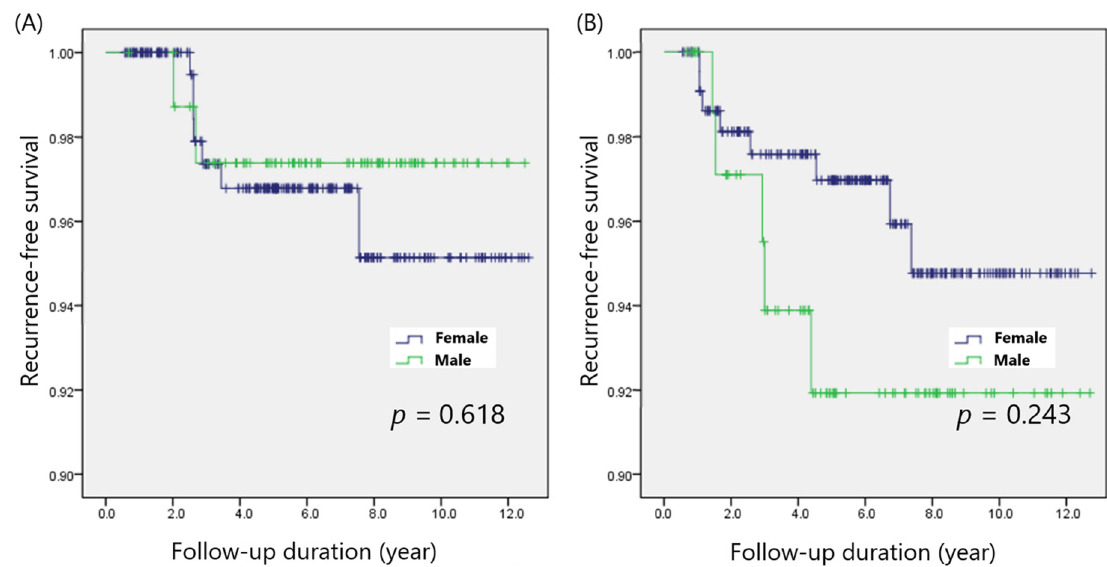
Figure 3. Disease-free survival in patients with ( A ) PTMC and ( B ) non-PTMC.